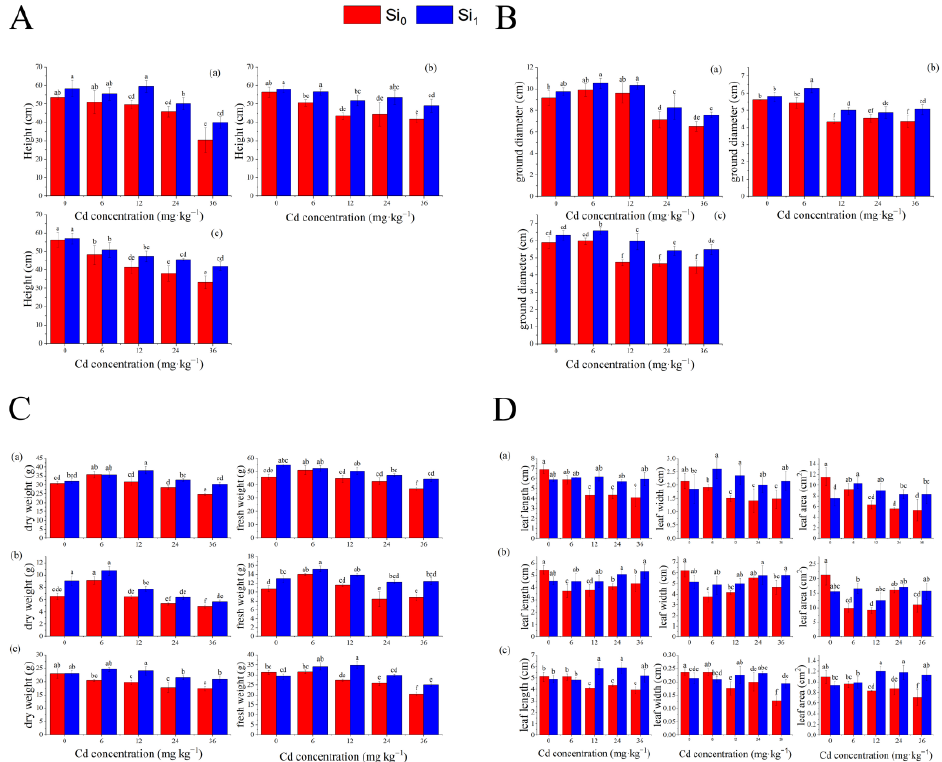
Figure 1. Effects of Cd and Si on growth parameters of seedling for ( A ) Schima superba , ( B ) Chinese sweetgum, and ( C ) Chinese fir. Uppercase letter beside each graph represent height, ground diameter, biomass production and leaf morphological traits for ( A – D ), respectively. Each value is a mean of six repetitions. Lowercase letters above the bars indicates significant differences according to Turkey test ( p < 0.05).